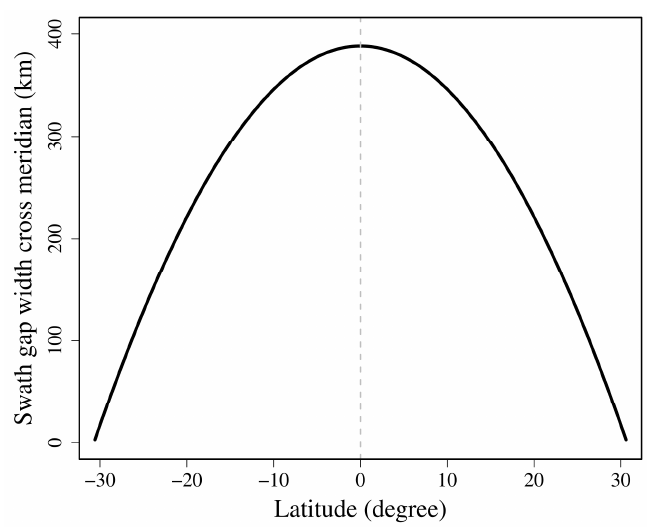
Figure 3. Cross-meridian width of a MODIS swath gap along latitude (the gray dash line indicates the equator).